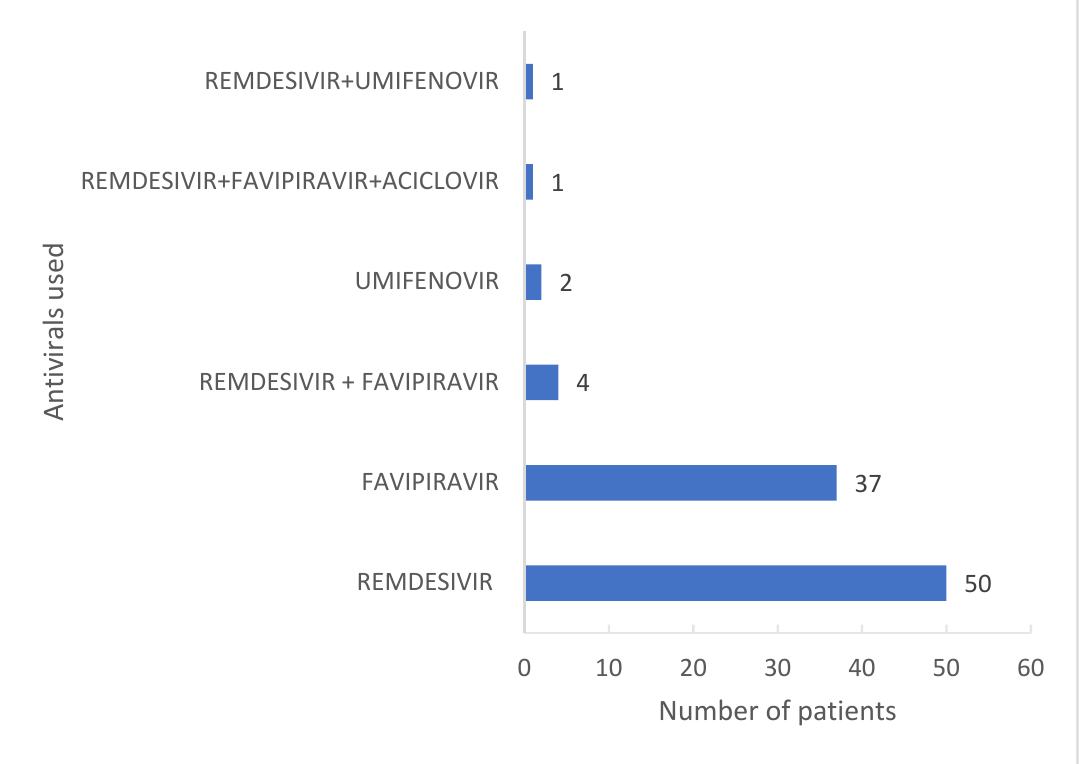
Figure 1. Antivirals used against COVID-19.